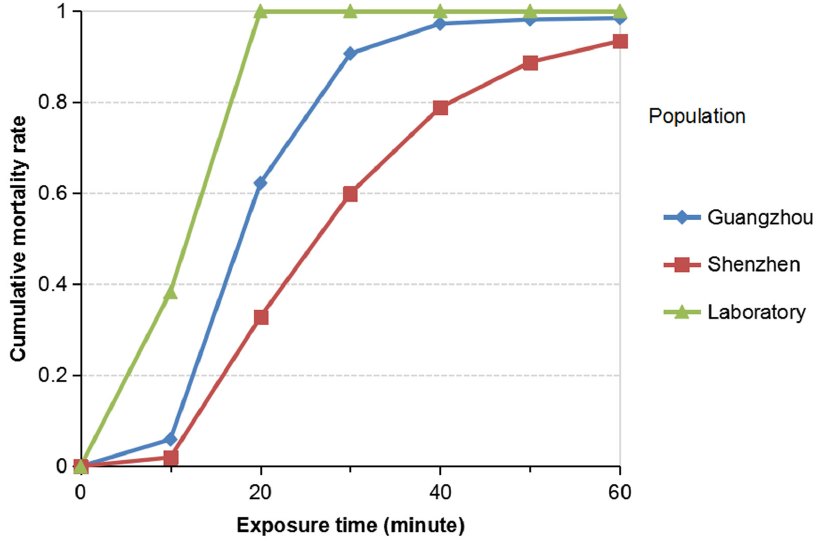
Fig 2. Cumulative mortality of Aedes albopictus against exposure time in two field population from southern China and the laboratory susceptible